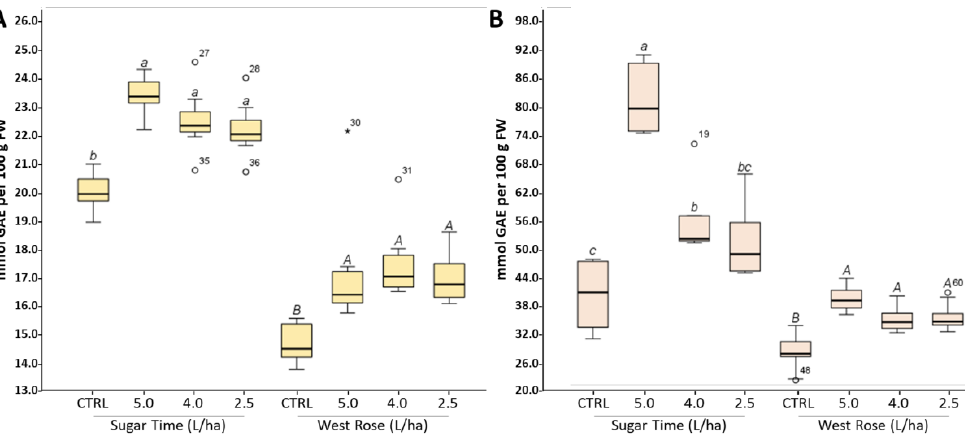
Figure 2. Total polyphenol content (TPC) measured in the pulp ( A ) or peel ( B ) of peaches harvested from trees treated with different dosages of biostimulant (5.0, 4.0 or 2.5 L/ha) or with water alone. In the different panels, CTRL identifies samples harvested from trees treated with water only. Values are expressed as mmol of gallic acid equivalent (GAE) per 100 g of fresh weight (FW). Within each box, the horizontal, black lines indicate median values, while the boxes extend from the 25th to the 75th percentile of the distribution of the values in each group. Moreover, the extended vertical lines indicate standard deviations. For each panel, within the same variety ( “ Sugar Time ” or “ West Rose ” ) the different lowercase (var. Sugar Time) or uppercase (var. West Rose) letters indicate significant differences at p ≤ 0.05, as measured by Tukey’s multiple interval test. The letter “ a ” indicates the highest value.